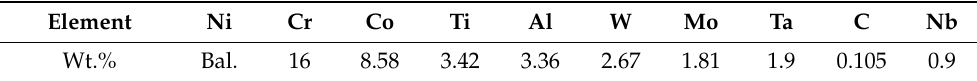
Table 1. Composition of IN-738LC